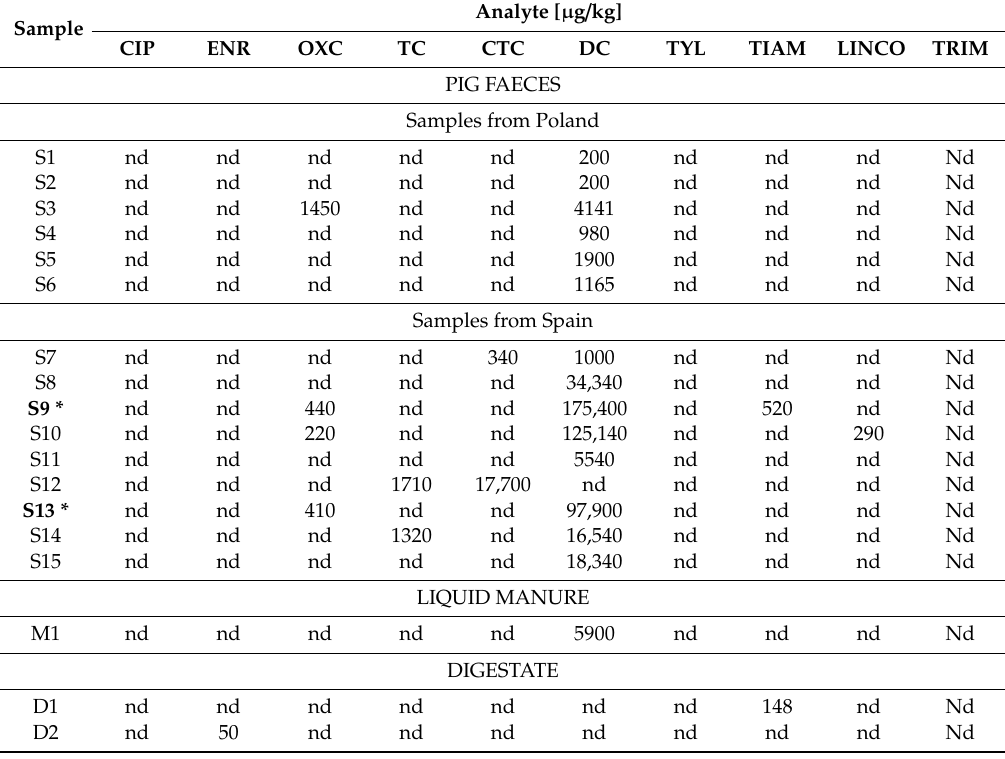
Table 2. The analytes and their concentrations detected in real